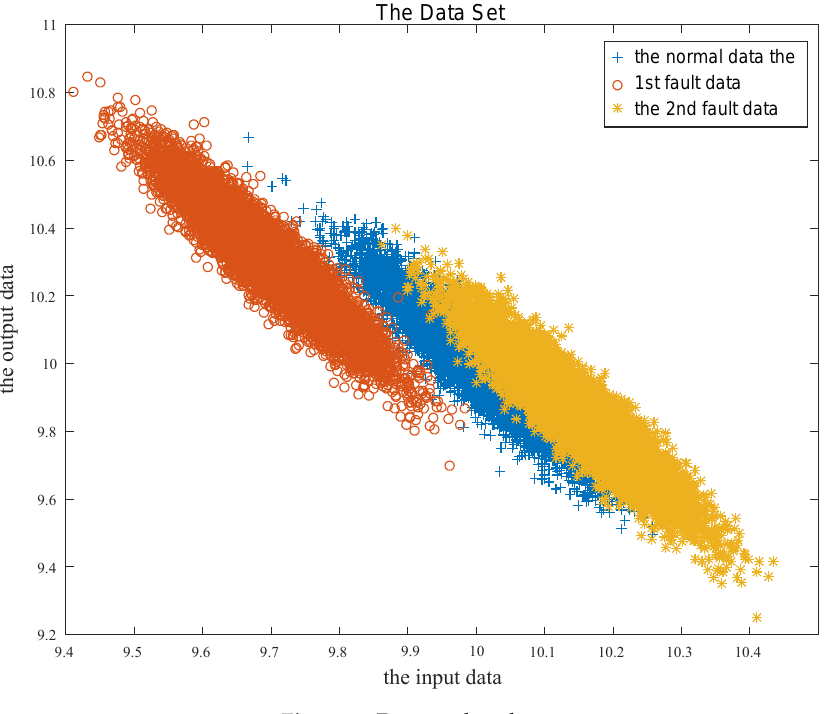
Figure 5. Dataset dot plot.